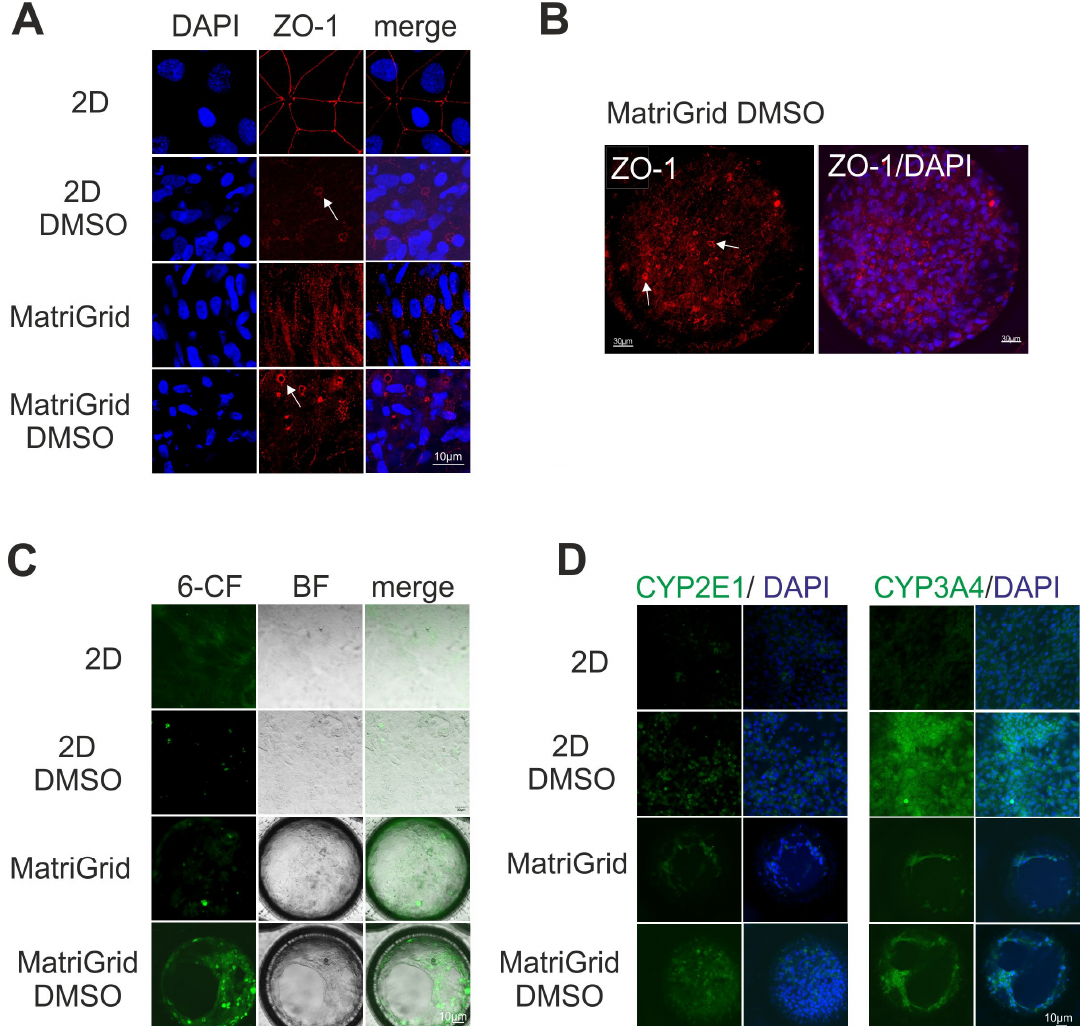
Figure 2. Immunofluorescence staining of markers of hepatofunctionality and polarity of monolayer (2D) and 3D HepaRG cells cultured without or with 1% dimethyl sulfoxide for 28 days. ( A ) The tight junctional marker ZO-1 labels bile pocket-like structures only in differentiated adjacent HepaRG- cells (visible as small holes between the hepatocytes and indicated by arrows). ( B ) Confocal image showing ZO-1 and DAPI staining in differentiated 3D (MatrGrid)-cultured HepaRG cells (arrows indicate bile canaliculi ). ( C ) The 6-carboxy-fluorescein (6-CF) diacetate excretion for detection of drug transport and bile canaliculi functionality. ( D ) Detection of CYP2E1 and CYP3A4 in undifferentiated and differentiated HepaRG cells (drug metabolism). All the stainings were performed three times. BF: brightfield.